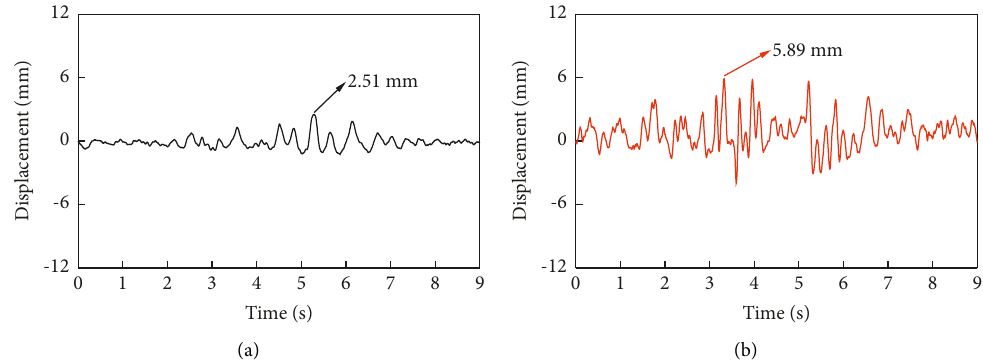
Figure 8: Displacement at the top of specimen for (a) (x) direction and (b) (y) direction at 0.45g earthquake excitation.